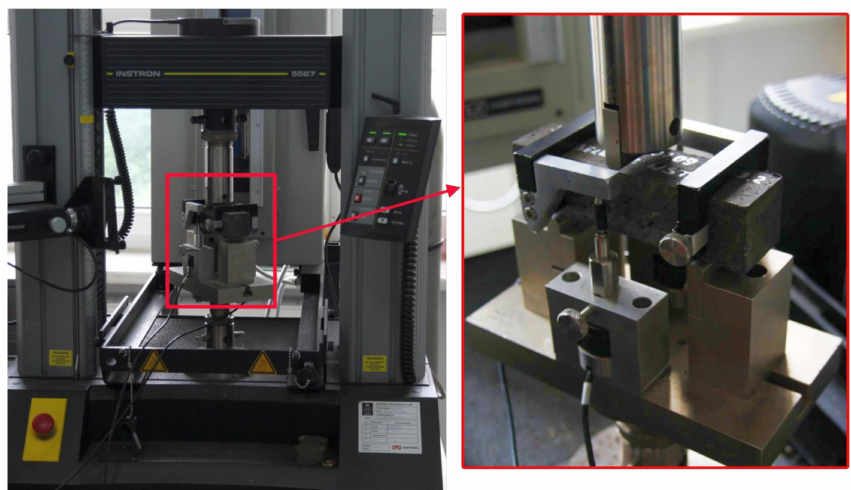
Figure 2. Bending strength test on Inston 5567 machine.